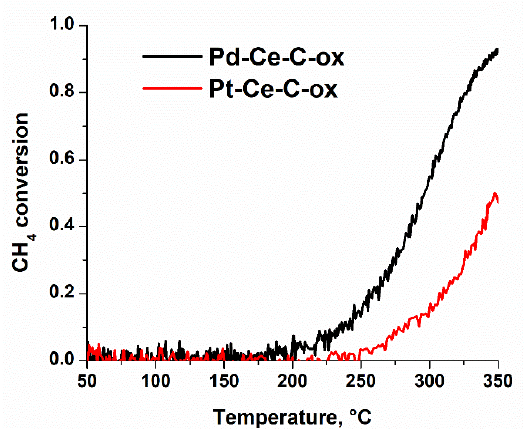
Figure 6. TPR-CH 4 +O 2 data. The temperature dependences of CH 4 conversion during the third heating run of the samples in the reaction mixture in the TPR-CH 4 +O 2 mode for Pd-Ce-C-ox and Pt-Ce-C-ox catalysts.